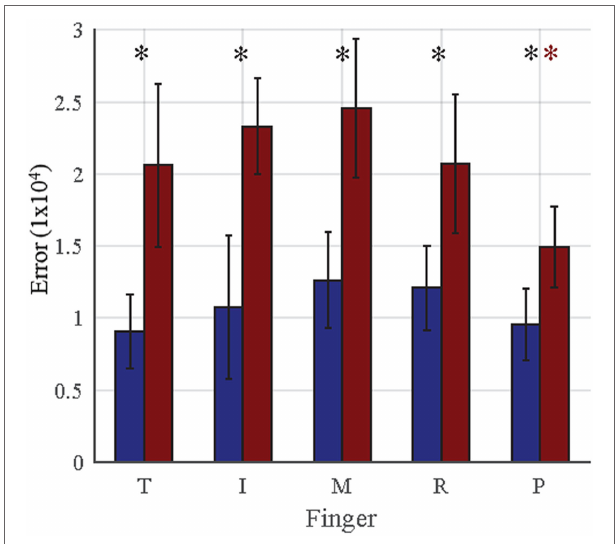
FigUre 9 | For each finger, the mean euclidian error between template and entry postural synergies is shown . Blue bars represent mean taken across all authentic attempts, and red bars represent mean taken across all imposter attempts. Error bars represent 1 SD. For authentic attempts, no significant differences are seen across fingers. For imposter attempts, the pinky showed significantly less error (indicated by the red star, p < 0.05) than all other fingers. In every finger, imposter attempts averaged significantly greater (indicated by the black star, p < 0.01) error than authentic attempts.